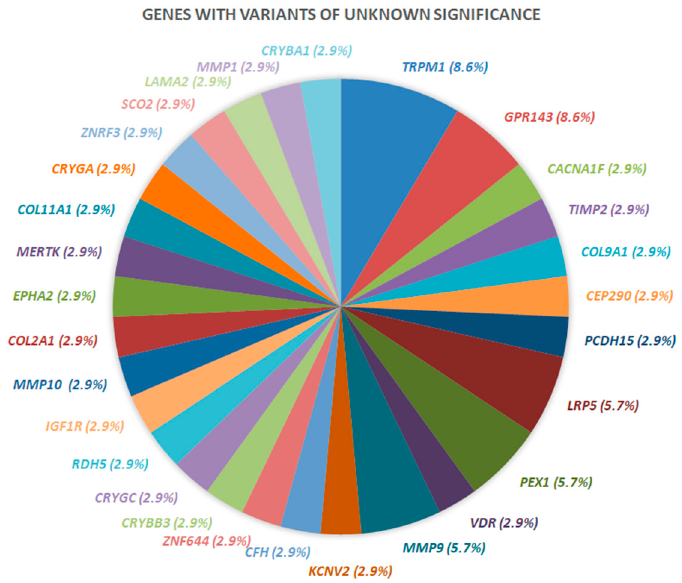
Figure 6. Representation of genes with variants of unknown significance and their proportion.